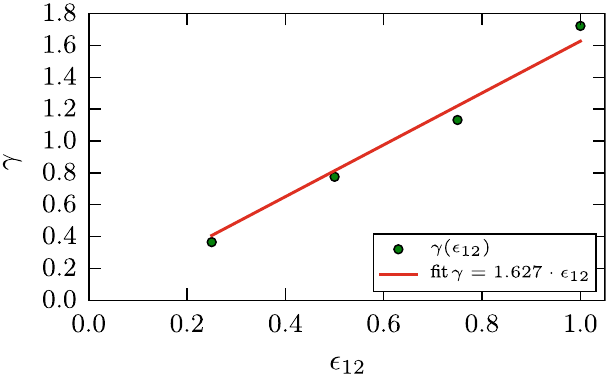
Figure 2. Dependence of the surface energy γ on the intergrain attraction ǫ 12 .